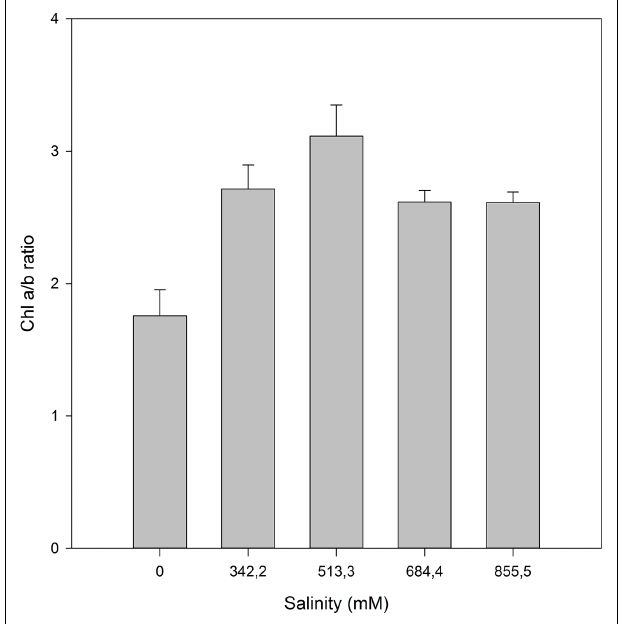
FIGURE 9 | Kautsky curve and K-step fluorescence (arrow) from Aster tripolium individuals exposed to a salinity gradient during 15 days (average values, N = 5). FIGURE 10 | Chlorophyll a/b ratio in H. portulacoides leaves from individuals exposed to a salinity gradient (average ± SE, N = 5).